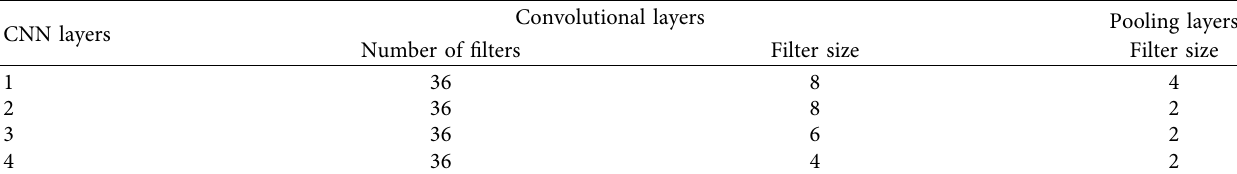
Table 1: The structures of the employed DCNN-Adam